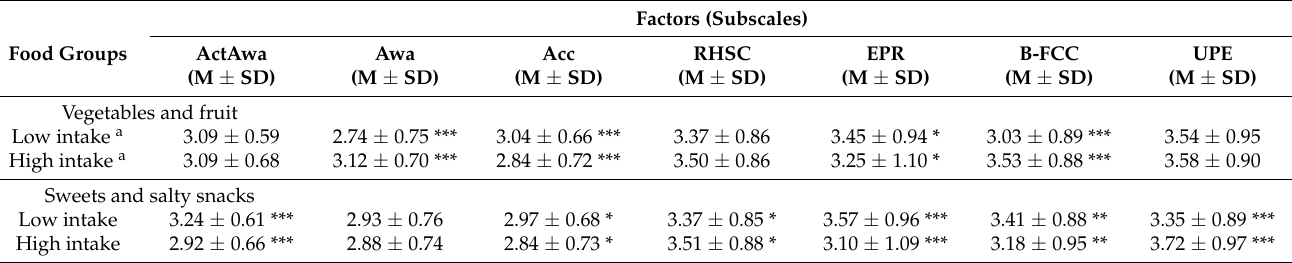
Table 11. Discriminant validity of IES-2 and MES subscales.